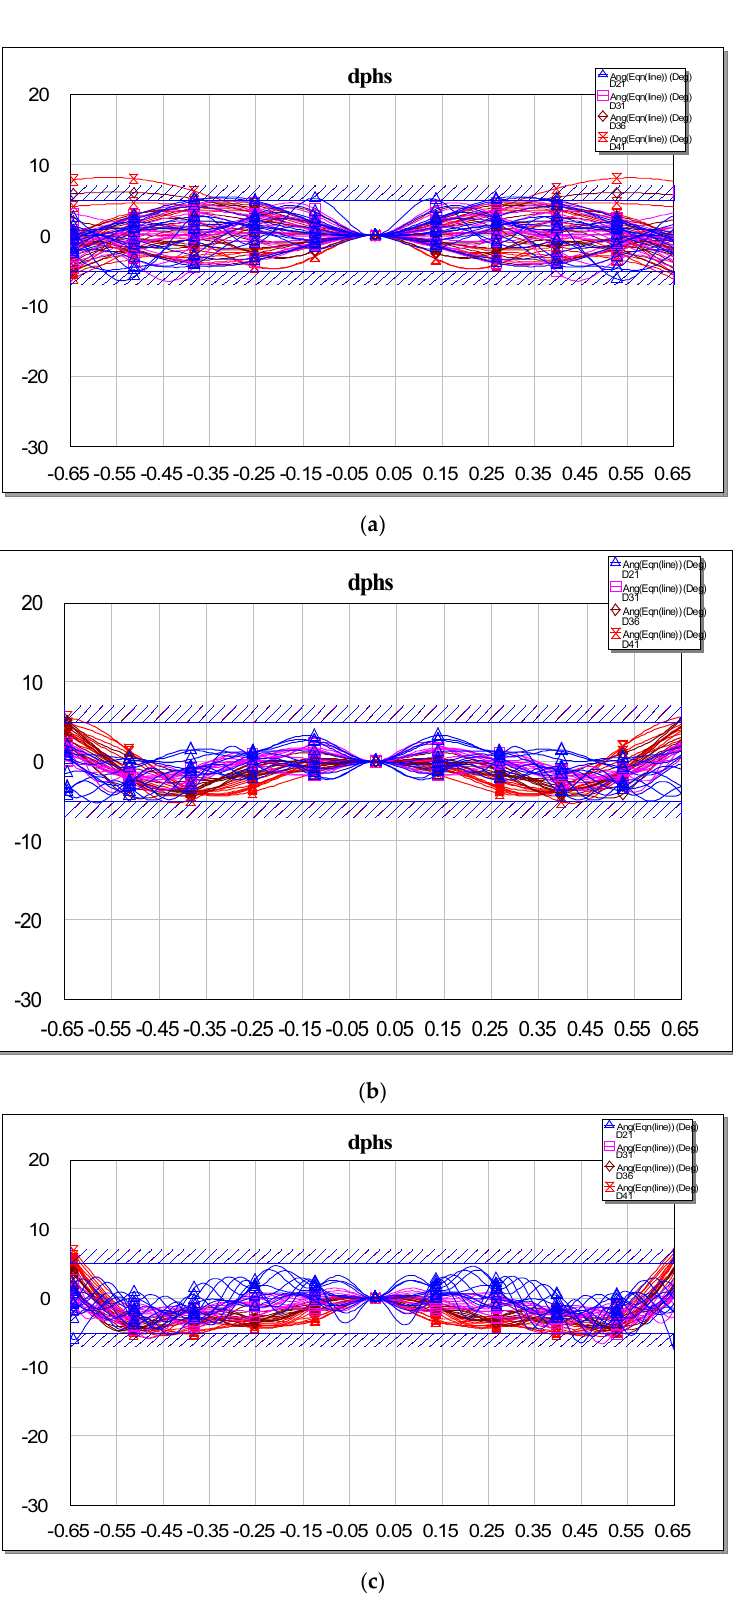
Figure 13. Phase variation of composite pattern fields at different frequency points on observation lines at different distance (2 m, 2.5 m, 3 m, and 3.5 m). ( a ) 700 MHz–2.0 GHz. ( b ) 2.0–3.0 GHz. ( c ) 2.0–3.0